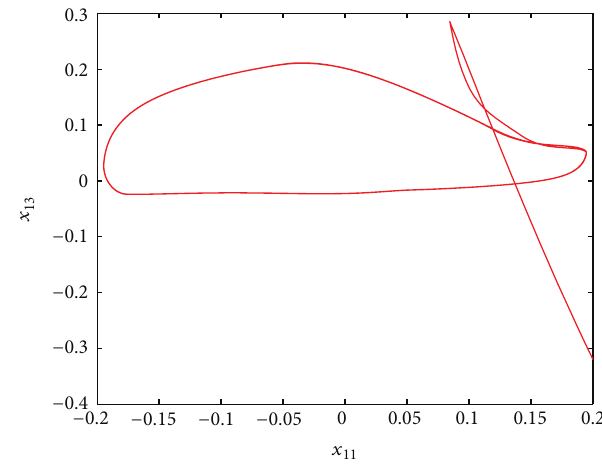
Figure 2: Phase response of state variables 𝑥 11 and 𝑥 13 in Example 1.